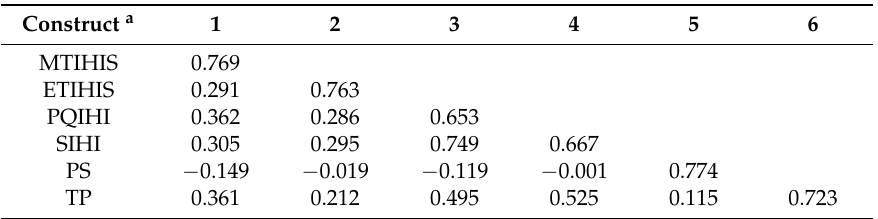
Table 5. Correlations of Latent